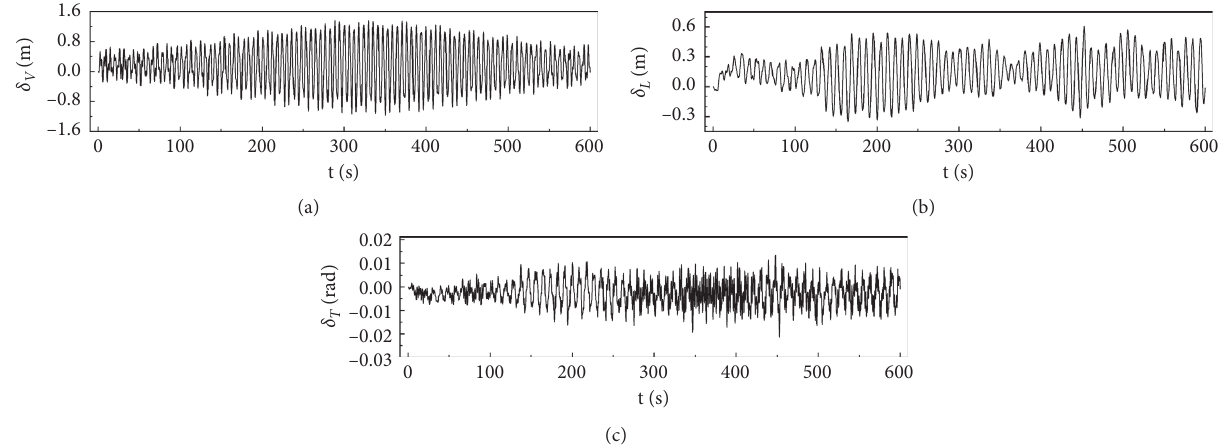
Figure 12: Time histories of the (a) vertical, (b) lateral, and (c) torsional buffeting displacements at the midspan (#15) of Case 1. AoA � 0 ° .